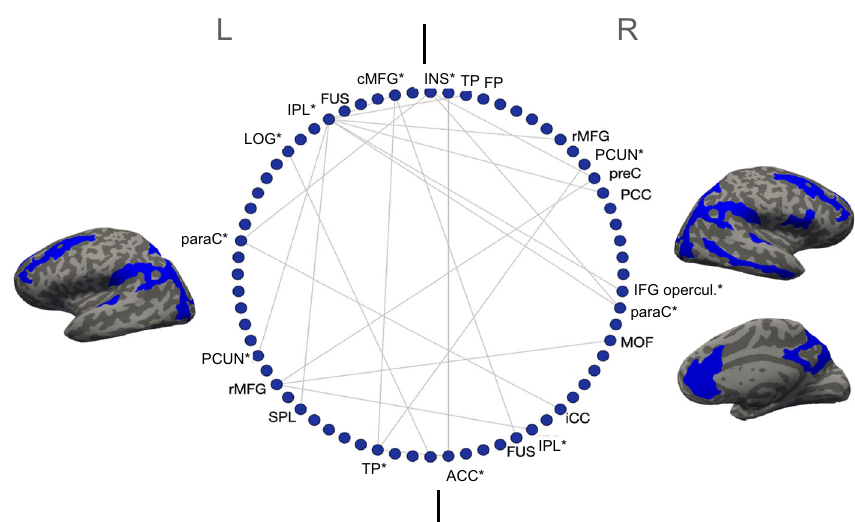
Fig. 7 Regions with the most signi fi cant difference in inter-regional correlations of surface area between the groups: these correlations were signi fi cantly greater for PD-VH. Only the inter-regional correlations with a difference greater than 0.3 in the r 2 are shown; the regions with the greatest number of signi fi cant inter-regional correlations, signi fi cant after multiple comparisons correction, are marked with a * (for details see S8). IPL inferior parietal lobule, SPL superior parietal lobule, LOG lat. occipital gyrus, MTG middle temporal gyrus, STG superior temporal gyrus, cMFG caudal middle frontal gyrus, PHG parahippocampal gyrus, paraC paracentral gyrus, preC precentral gyrus, IFG inferior frontal gyrus, SFG superior frontal gyrus, SMAR supramarginal gyrus, FP frontoparietal thickness, TP temporoparietal, FUS fusiform gyrus, CUN cuneus, PCUN precuneus, MOF middle orbitofrontal gyrus. The two vertical lines separate L and R hemisphere regions (left on